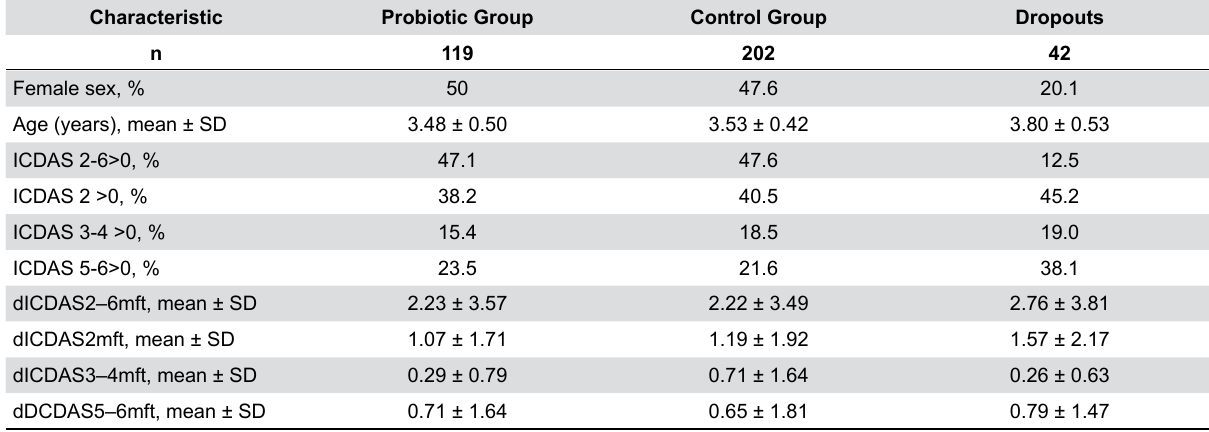
Table 1- Baseline characteristics of children who participated in the study